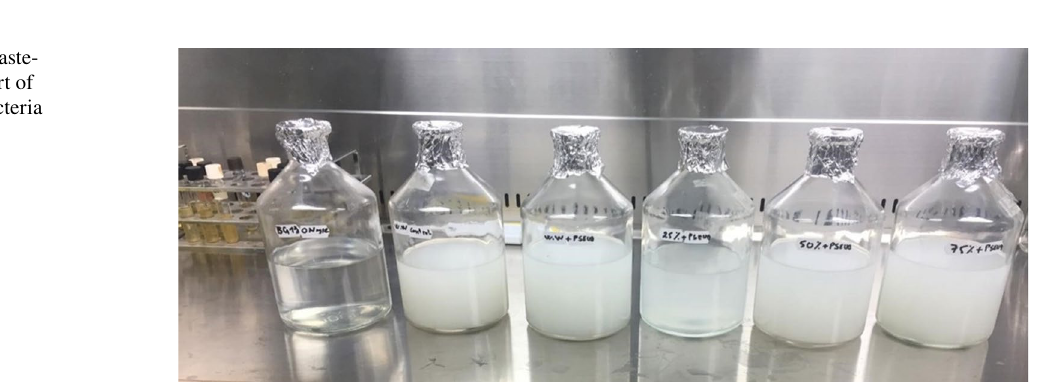
Fig. 2 Appearance of waste- water samples at the start of treatment with cyanobacteria Pseudanabaena galeata